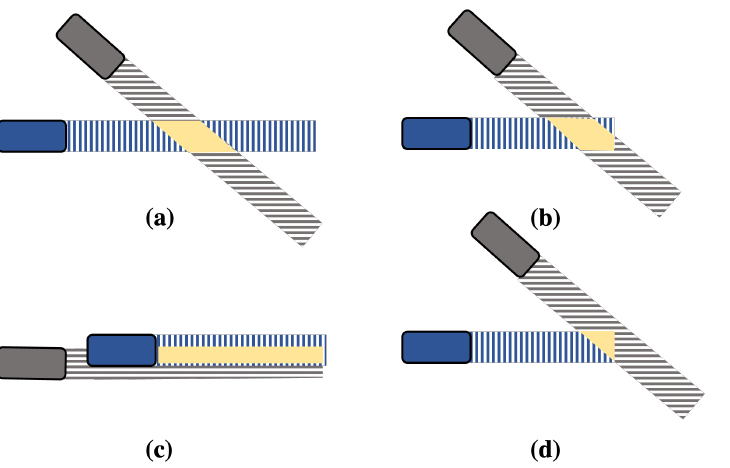
Figure 4. Intersecting relationship. ( a ) general interacting scenarios 1 ( b ) specific situation 1 ( c ) general interacting scenarios 2 ( d ) specific situation